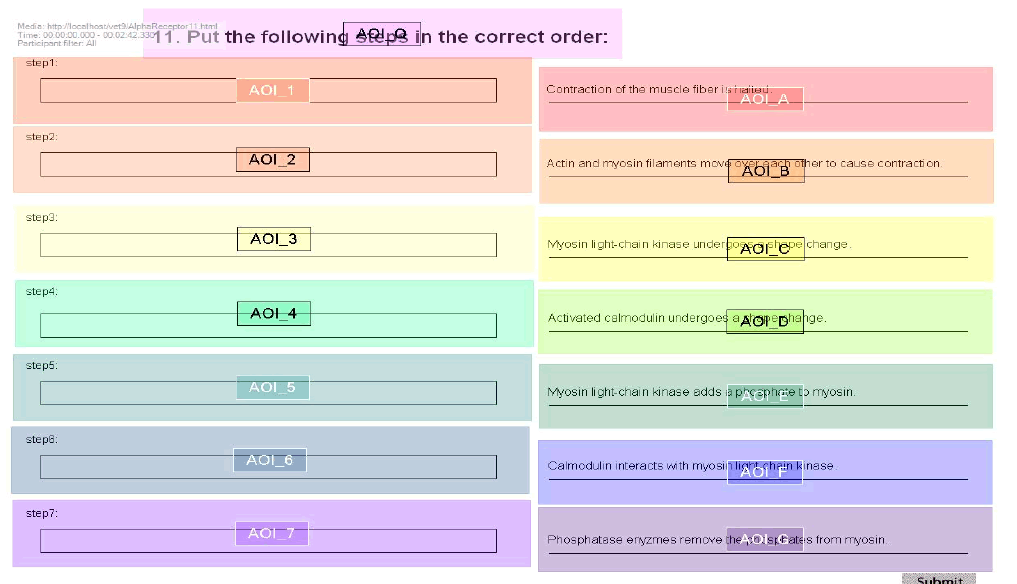
Figure 2. Superimposition of area of interest (AOI) fields on the screen capture of the third ordering problem. AOIs 1 through 7 are for the steps (left side), AOIs A through G are for the choices (right side), and AOI_Q is for question